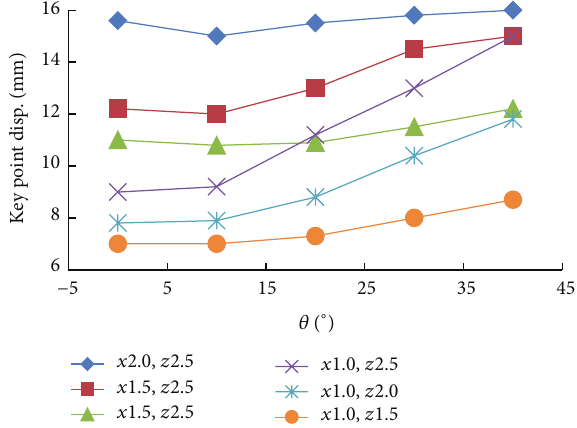
Figure 25: Key point displacement versus 𝜃 in case 3 .